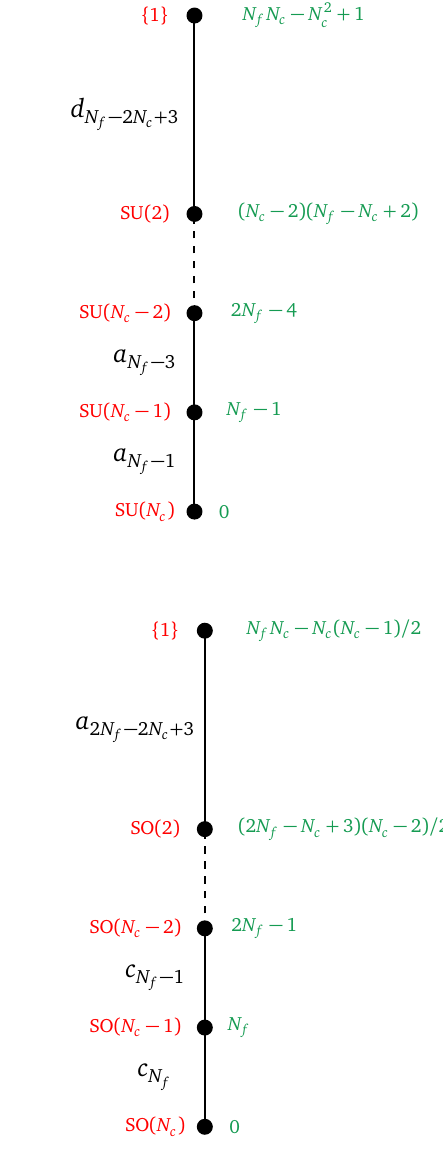
Figure 1: Comparison between the Higgs branch Hasse diagram for theories with ) (top left) and SU ( N ) (top right) and for theories with O ( N U ( N c c ) (bottom right) gauge groups, with the number of fundamental flavours and SO ( N c ≥ N N satisfying N . The green numbers are the quaternionic dimensions of the f f c leaves, and the red groups are the residual gauge